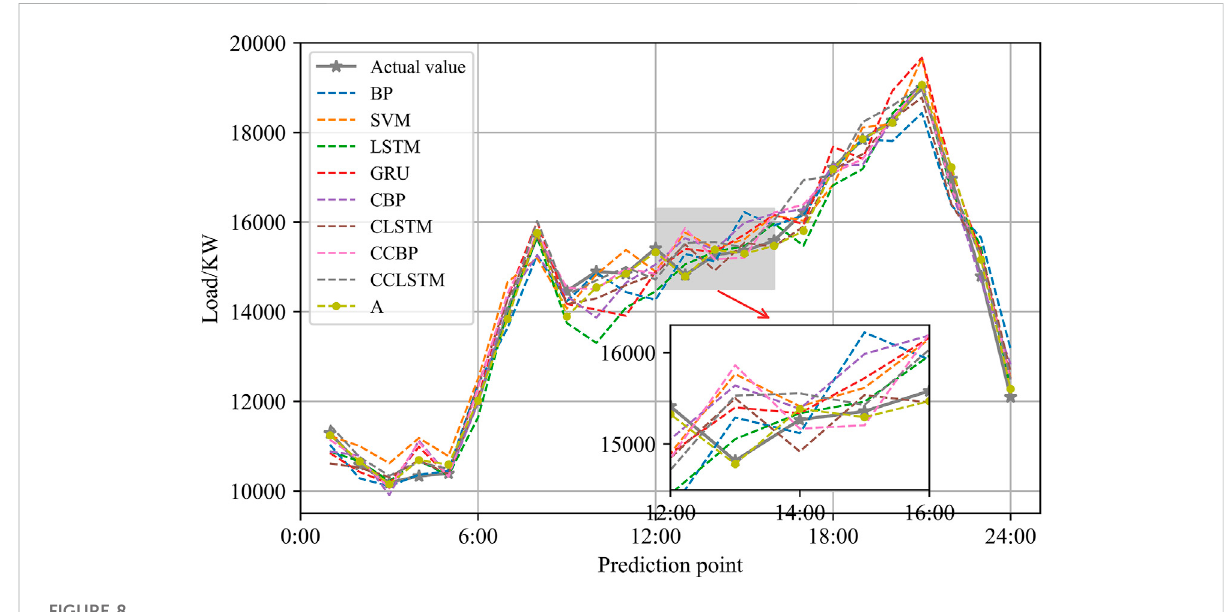
FIGURE 8 Forecasting error comparison of different forecasting